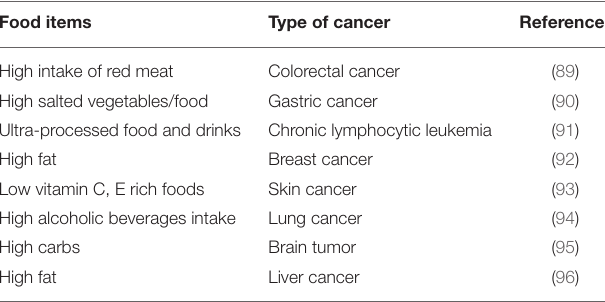
TABLE 3 | Linkage of certain foods to various